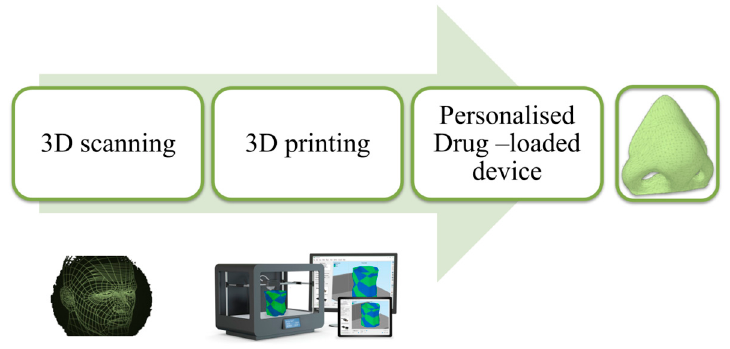
Figure 8. Customized modelling of anti-acne mask [18].